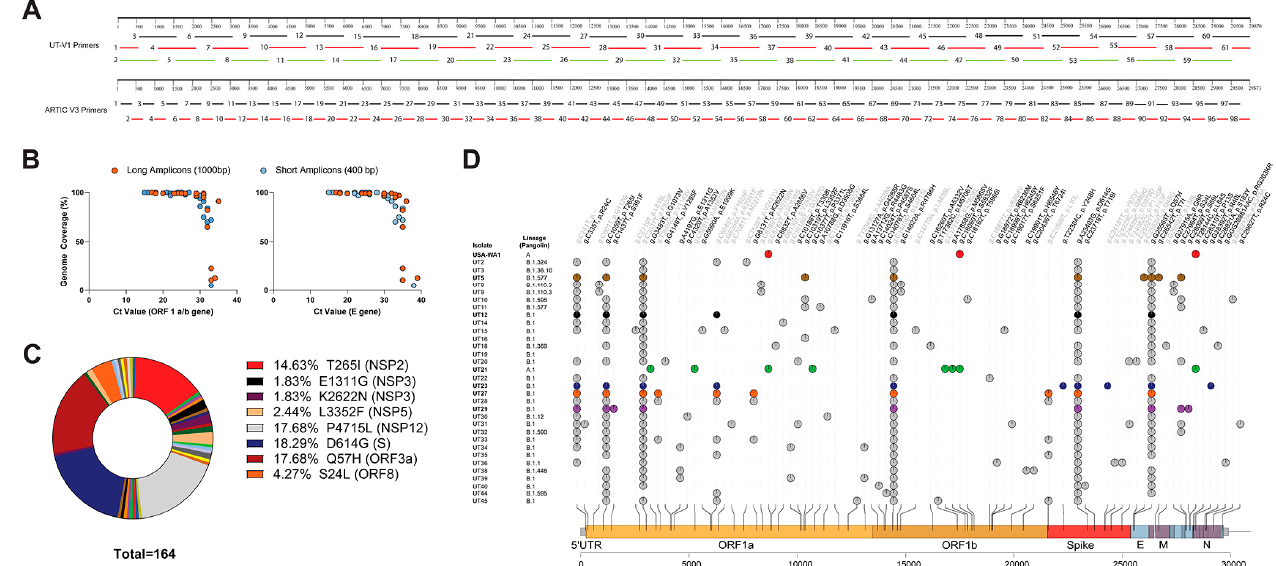
Figure 1. Single nucleotide polymorphisms and nonsynonymous mutations identified in SARS-CoV-2 nasopharyngeal samples. Schematic comparing two amplicon generation approaches ( A ) and the efficiency as defined by genome coverage as compared to Ct values ( B ). ( C ) Pie chart of the 162 nonsynonymous mutations identified from 31 sequences. The percentage of major nonsynonymous amino acid changes and corresponding gene location are listed to the right of the pie chart. ( D ) Variants associated with 31 high-quality clinical sample NGS sequences, and the SARS-CoV-2 WA1/2020 sequence, were mapped in comparison to the SARS-CoV-2 Wuhan-Hu-1 reference genome. Mutations observed across the genome are listed as gene (g.) or nucleotide change and its associated protein (p.) or amino acid change and variants are colored as synonymous mutations (grey) and nonsynonymous mutations (black). Mutations identified in virus isolates used in in vivo experimentation are colored as WA1/2020 (red), UT5 (brown), UT12 (black), UT21 (green), UT23 (navy blue), UT27 (orange), and UT29 (violet). Visualization of SNPs was designed using trackViewer v0.2.5 [39].